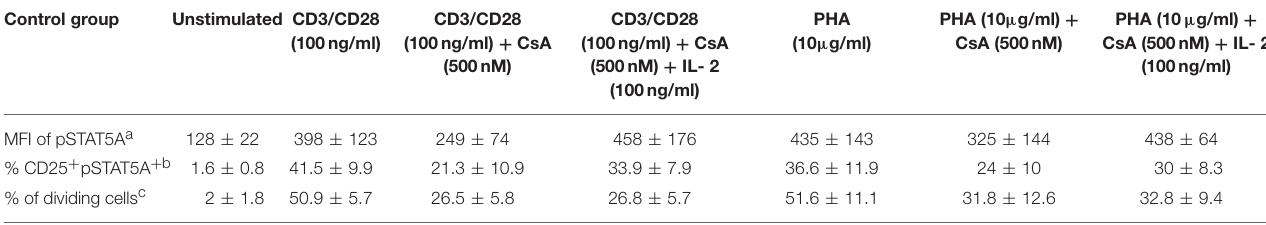
TABLE 3 | Summary of MFI of pSTAT5A, % of CD25 + pSTAT5A + cells and % of dividing cells before and after treatment with Cyclosporine (CsA) in CD3/CD28 and PHA stimulated cells ( n = 6). Control